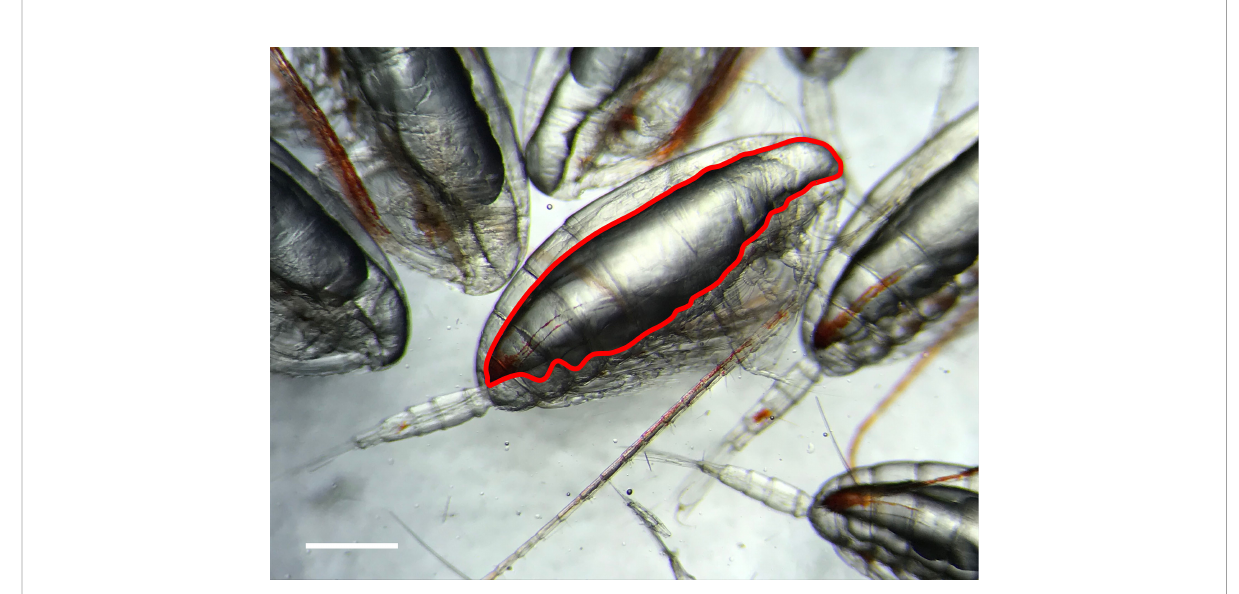
FIGURE 1 Fat-laden lipid sac (outlined in red) within Calanus fi nmarchicus ; scale bar is 1 mm. (image from Mayor et al., 2020; © D.J.